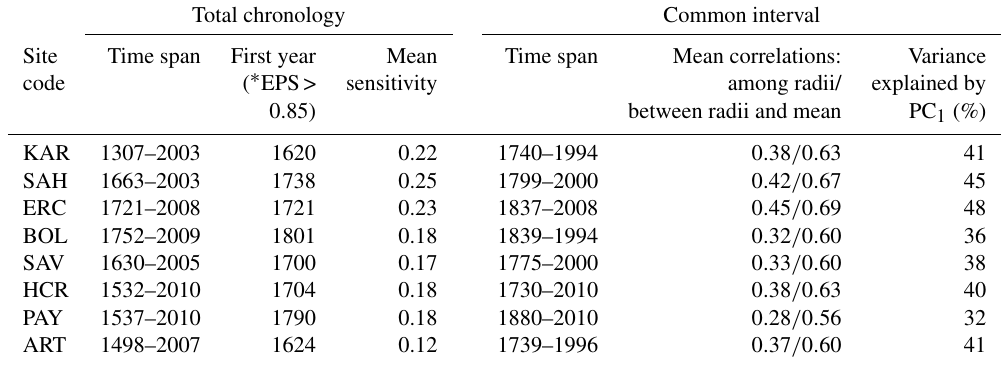
Table 2. Summary statistics for the new chronologies developed by this study in